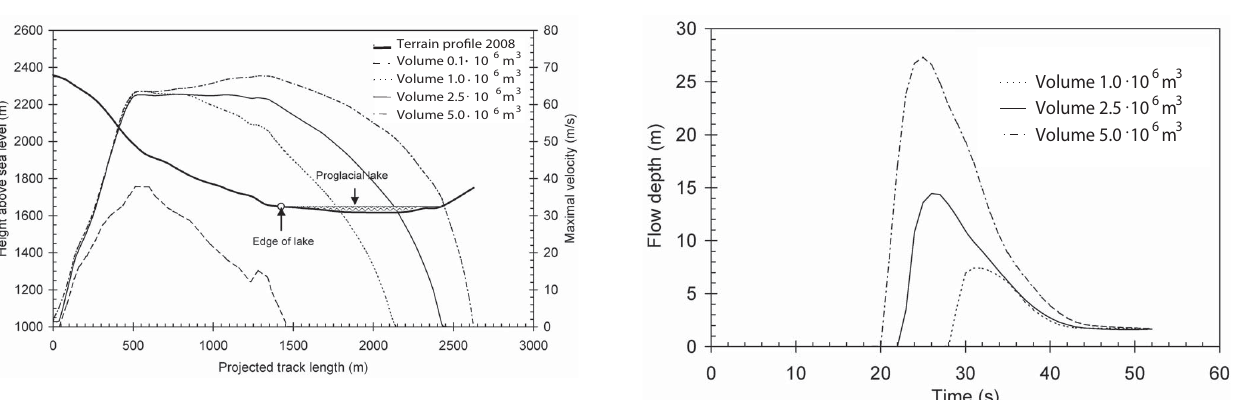
Fig. 12. Time plot of the flow depth at the position of the edge of the proglacial lake, for the surface geometry of Triftgletscher in 2008 calculated with